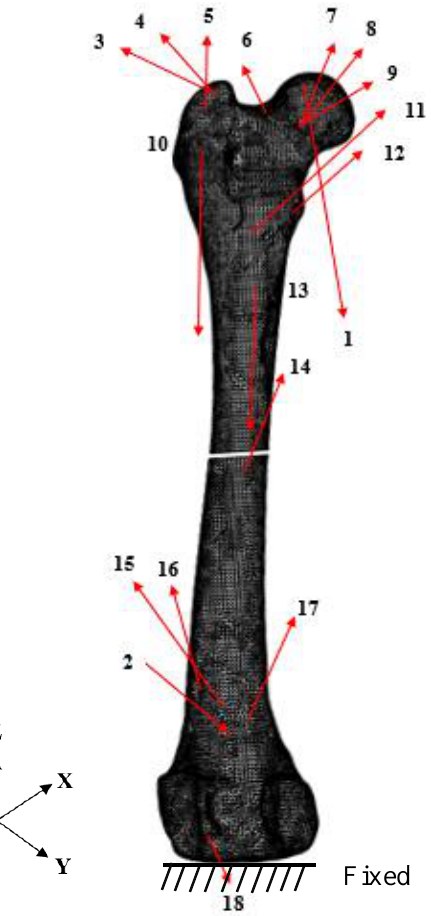
Figure 5. 3D FEA mesh of the canine femur, with loads applied. The directions of muscle force and joint reaction forces are indicated by the red arrows and numbers [25].